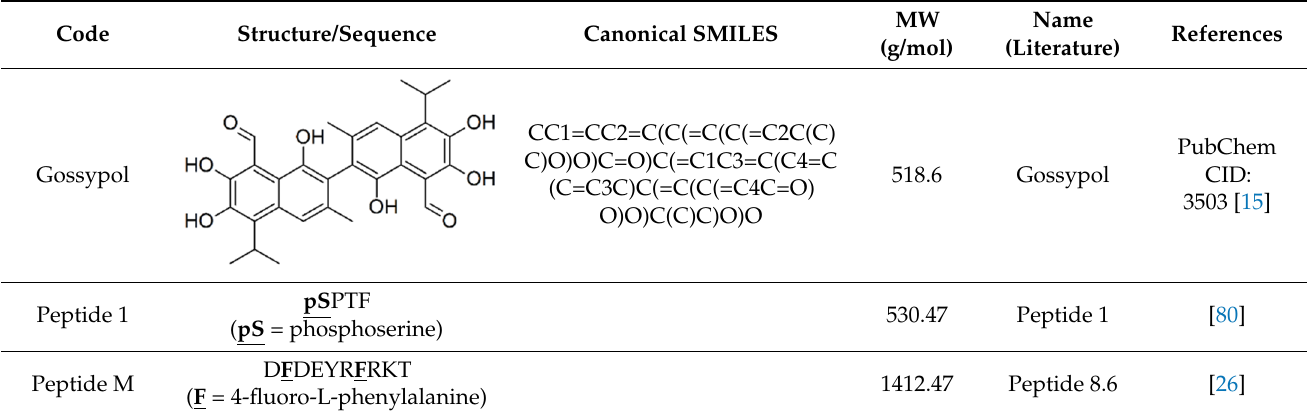
Table 6. Selected known ligands used for enrichment factor (EF) calculation during initial docking steps.